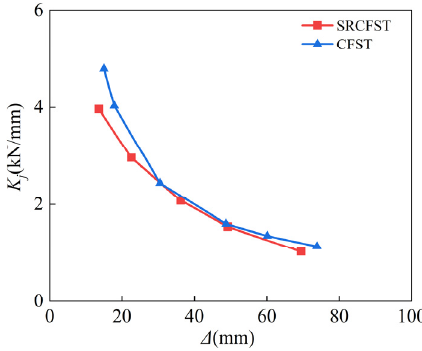
Figure 17. Comparison of stiffness degradation.